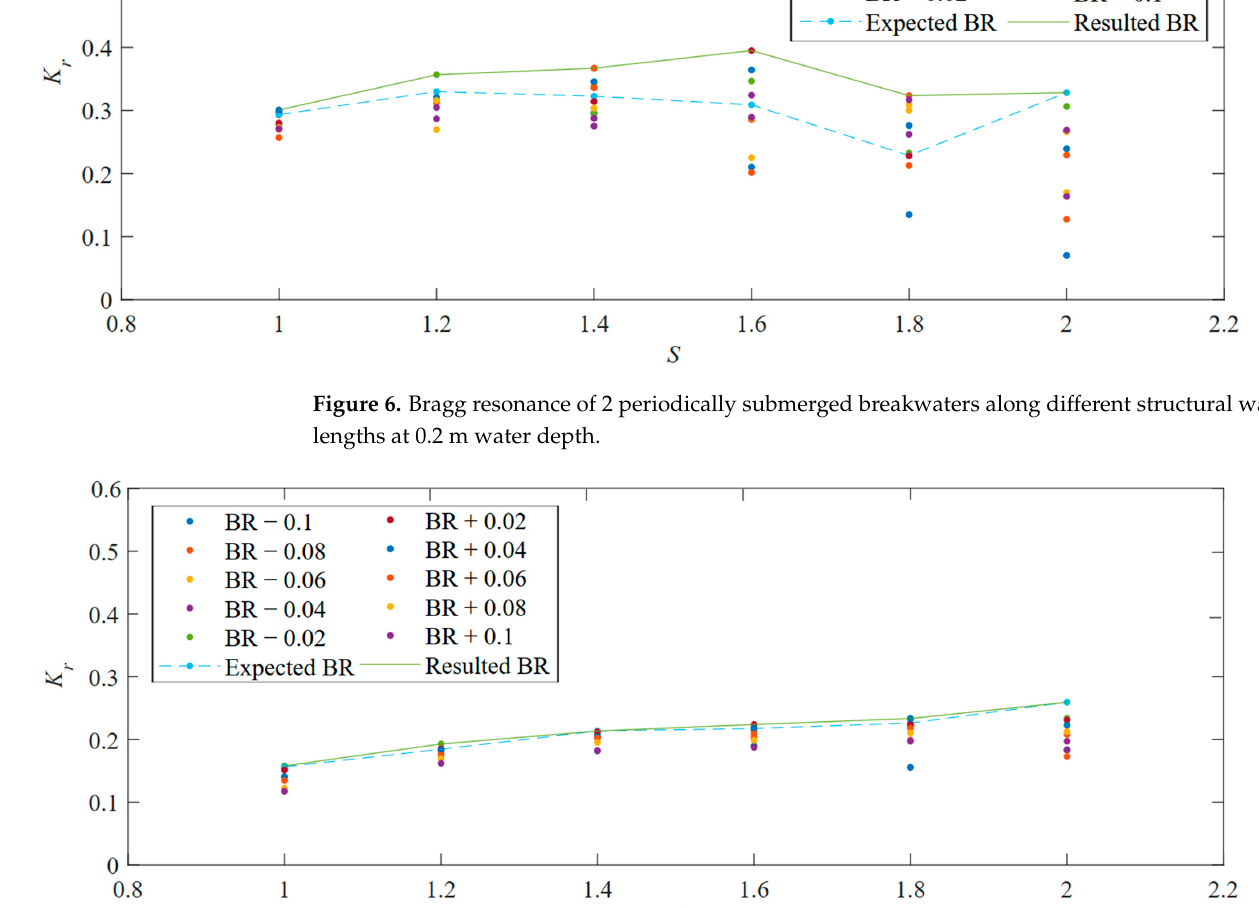
Figure 7. Bragg resonance of 2 periodically submerged breakwaters along different structural wave- lengths at 0.3 m water depth.